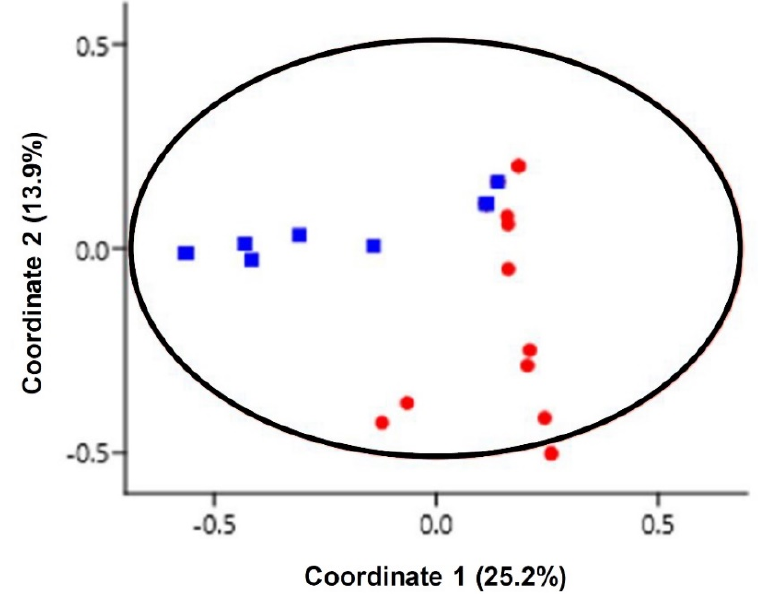
Figure 2. Principle coordinate analysis (PCoA) plots of marine yeast in 40 coral and zoanthid samples of site S1 (filled red circle) and S2 (filled blue square) using the Jaccard similarity coefficient.